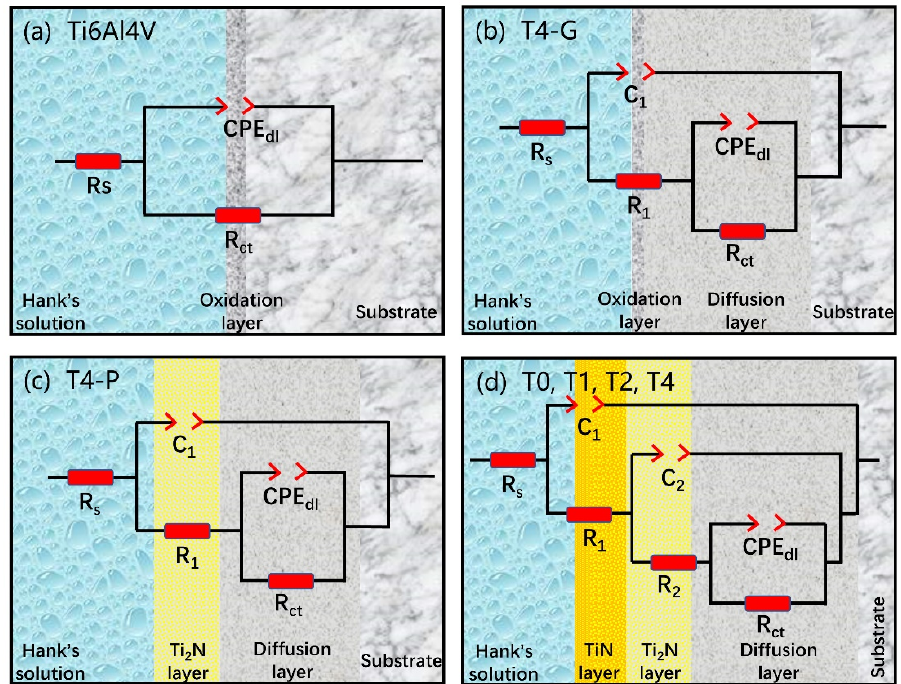
Figure 13. Simulated impedance circuit diagrams applied to different samples: ( a ) untreated Ti6Al4V samples. The simple impedance circuit with a time constant was used for the untreated samples to simulate the oxide layer resistance; ( b ) T4-G samples with surface mechanical grinding and polishing. A double-layer time-constant circuit was used to simulate; ( c ) T4-P samples with surface polishing; ( d ) T0, T1, T2, T4 nitriding samples. The unmechanically treated nitriding samples were fitted with a 3-time constant circuit. Table 4. Fitted circuit values for untreated, mechanically ground and polished, and nitriding samples.